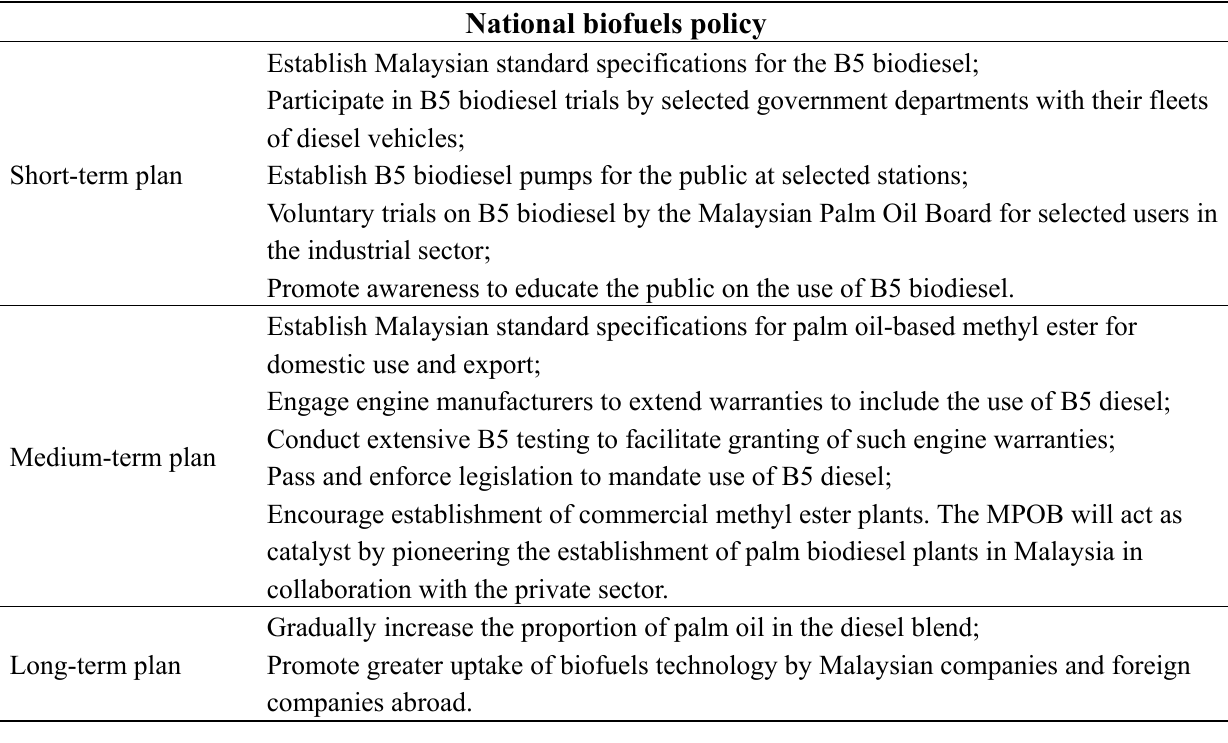
Table 10. A summary of the short, medium and long term of the national biofuels policy